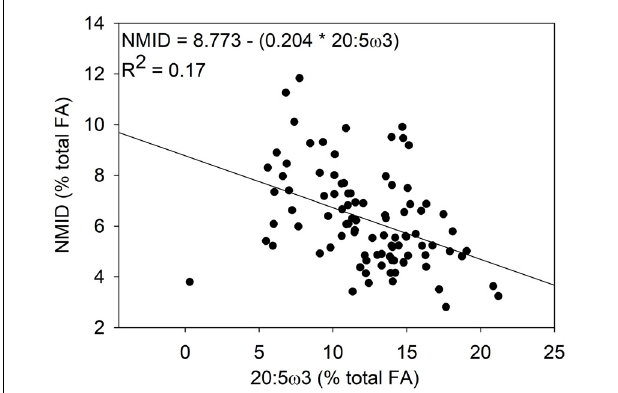
FIGURE 6 | Significant ( p < 0.05) linear regression of the proportion (%) of non-methylene interrupted dienes (NMID) and the essential fatty acid 20:5 ω 3 in Mytilus edulis from Saco Bay throughout 2016 and 2017. FIGURE 7 | Carbon ( δ 13 C) and nitrogen ( δ 15 N) biplot of Mytilus edulis and all